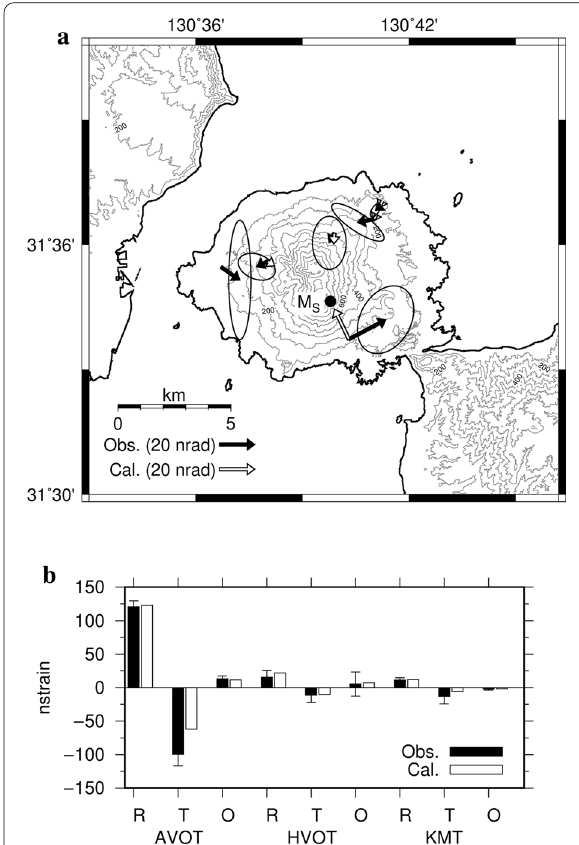
Fig. 4 a Location of the obtained spherical source ( M S , the solid circle) for phase 1 (22:07–22:10) and a comparison of the observed (black) and calculated (white) downward tilts. The error ellipses are 3 σ . The 99% confidence level estimated by an F -test (Árnadóttir and Segall 1994) is within the size of the solid circle. The depth of the source M S is 0.1 km bsl. b Comparison of the observed (black) and calculated (white) radial (R), tangential (T) and oblique (O) extensions. The error bars are 3